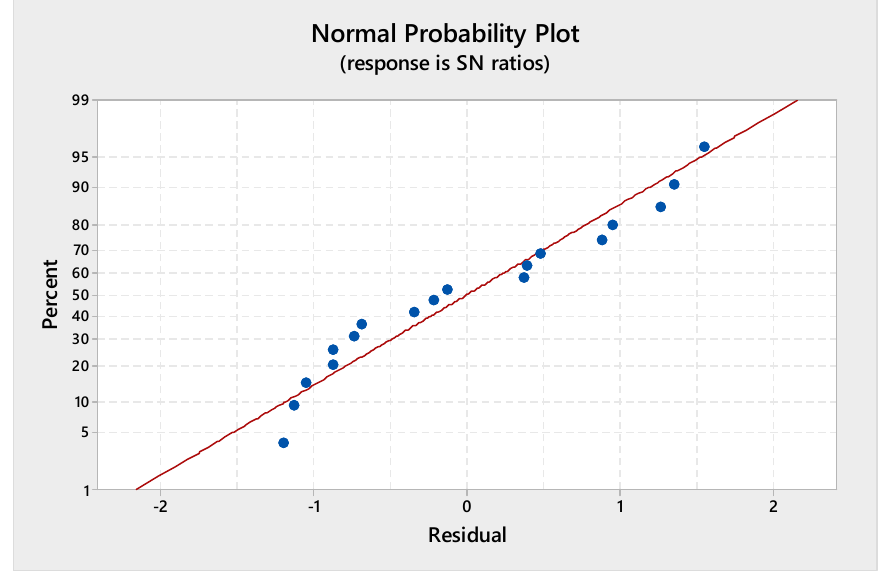
Figure 5. Normal probability plot.